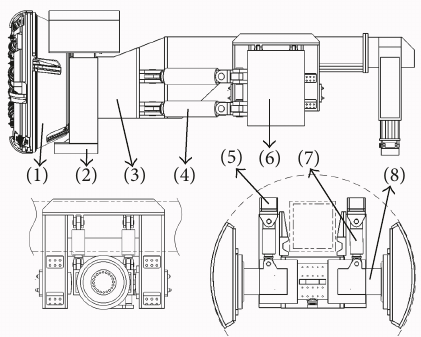
Figure 1: Schematics of an opening hard rock TBM. (1) Cutter head. (2) Shield. (3) Main beam. (4) Thrust cylinder. (5) Saddle. (6) Shoe. (7) Torque cylinder. (8) Support